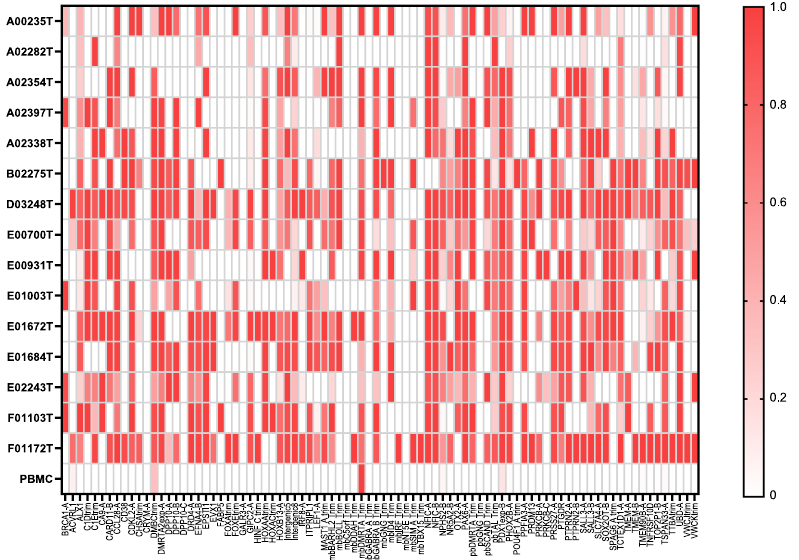
Fig. 4 mDETECT analysis of 15 TNBC tumours. The shading indicates the fraction of reads exhibiting methylation at all CpG residues in the region between primers compared to all reads, for the 86 probes in each of the 15 TNBC tumours analysed, as well as PBMC DNA from a normal individual. Each column represents an individual probe while each row represents a different tumour sample. Between 18 and 65 probes had a methylation fraction above 0.1 for each sample (average 46) while the PBMC sample had 2 positive